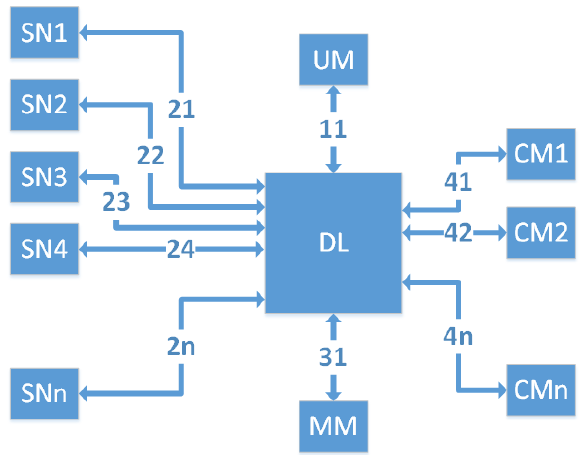
Figure 3: Block diagram of smart logistic unit.